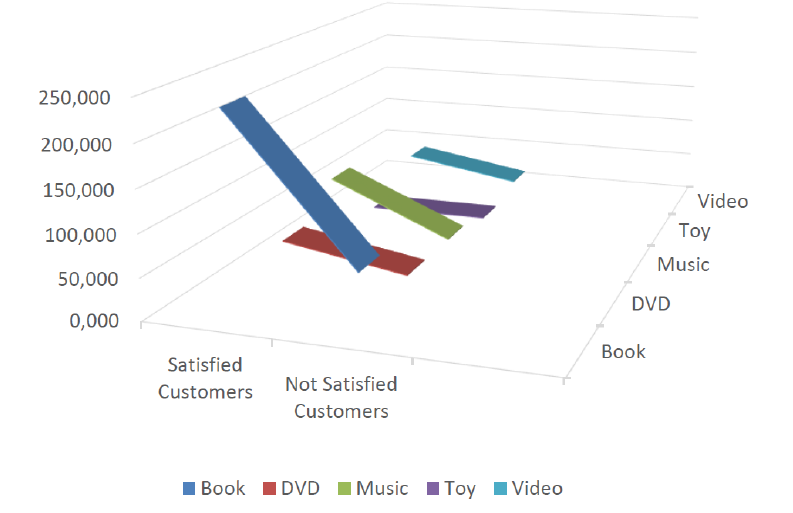
Figure 4. Customer